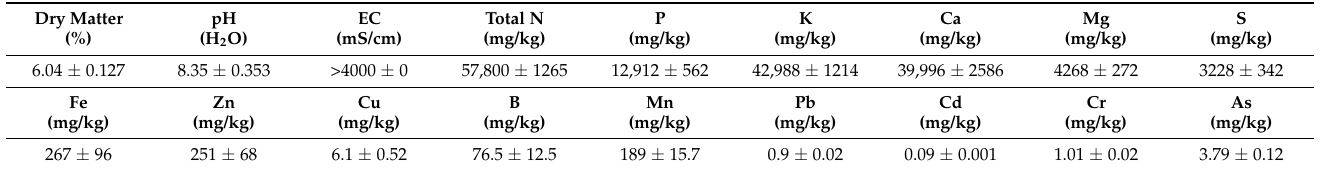
Table 3. Specifications of the LPD applied in dry